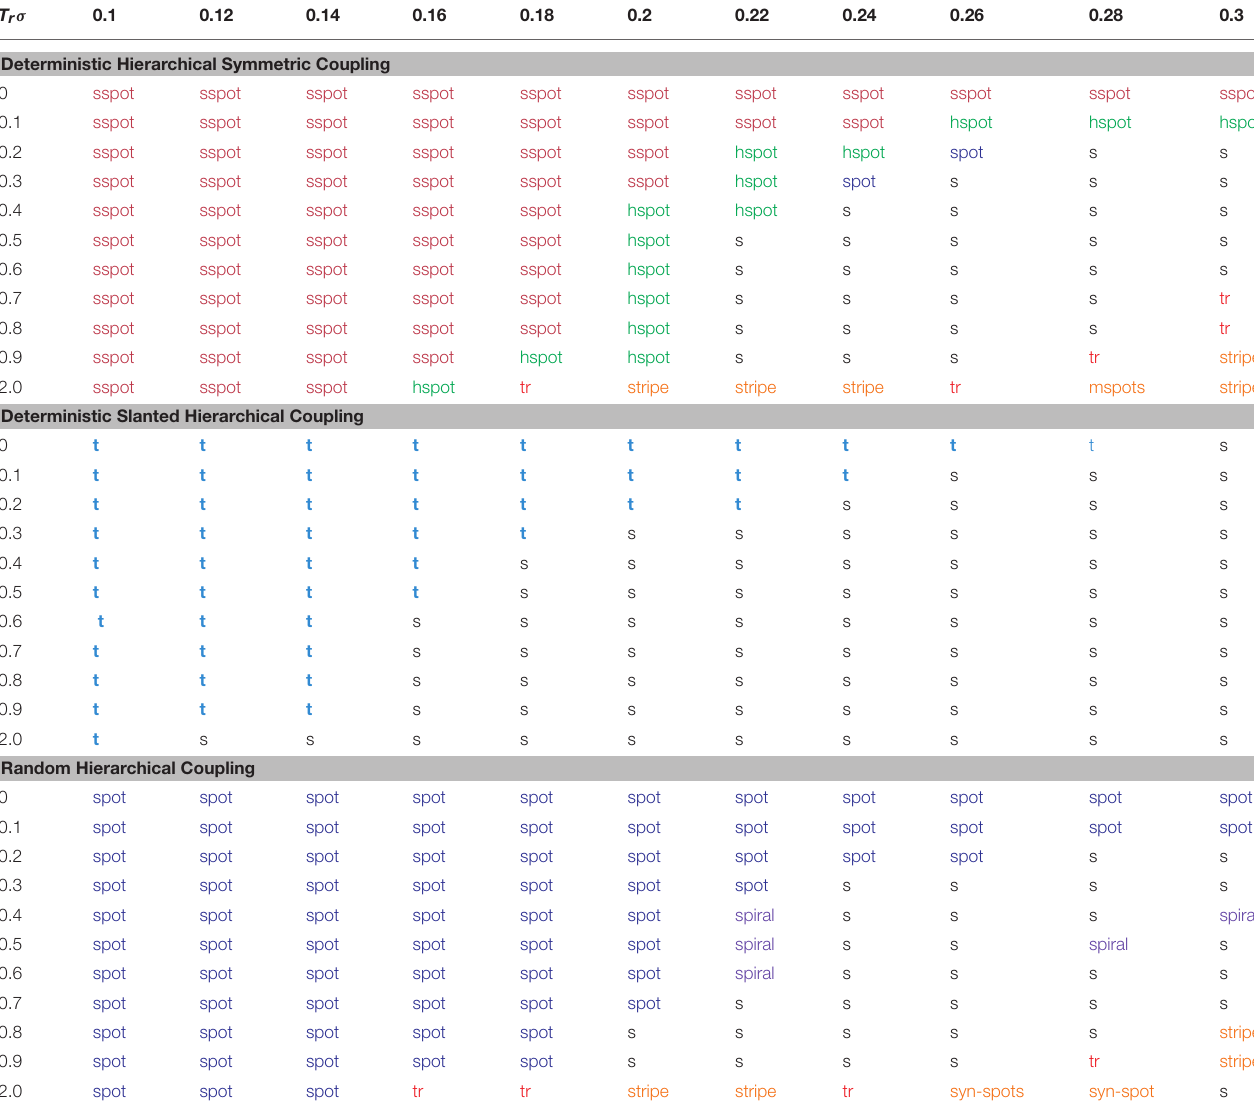
TABLE 1 | Collective presentation of the chimera patterns in the LIF model for σ ranging between (0.1–0.3) and T r in the interval from 0 to 2.0 time units. T r σ 0.1 Deterministic Hierarchical Symmetric Coupling